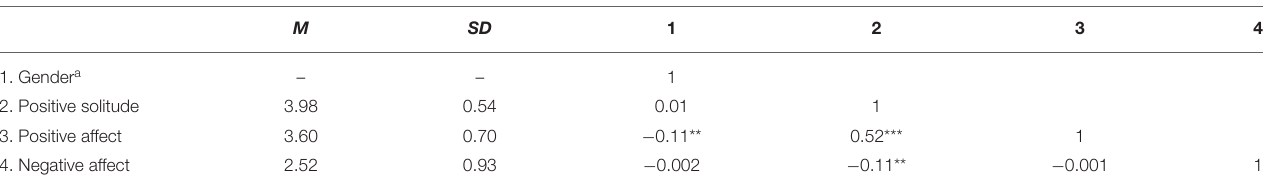
TABLE 2 | Descriptive statistics and correlation analysis of each variable.